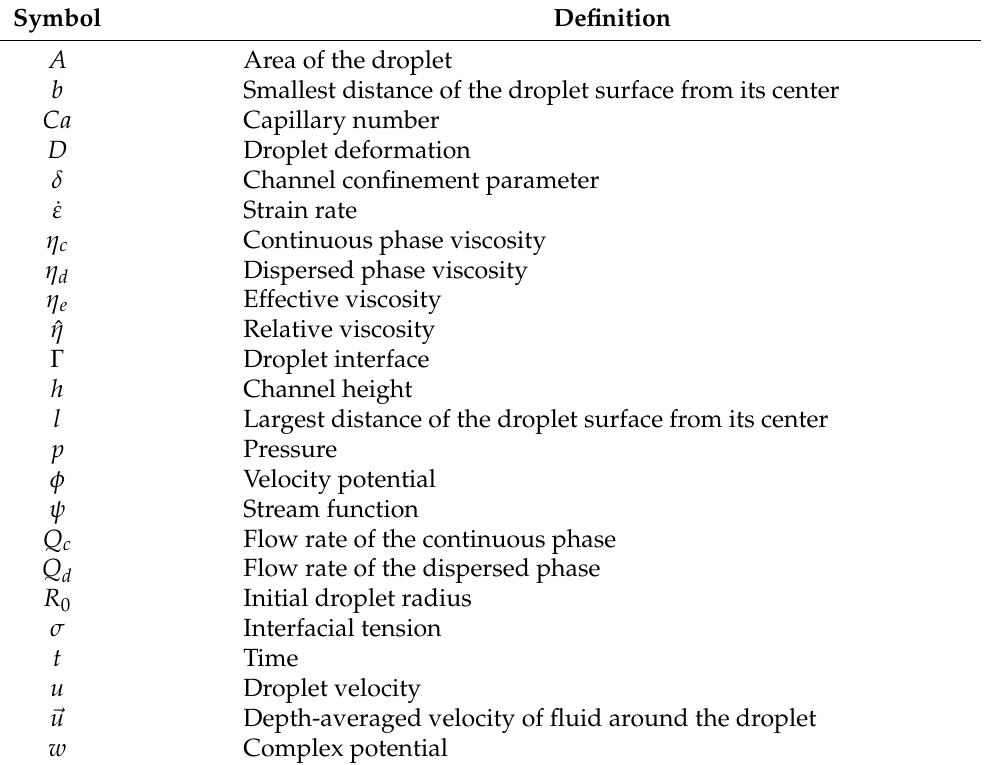
Table 1. Mathematical symbols and their definitions used in this